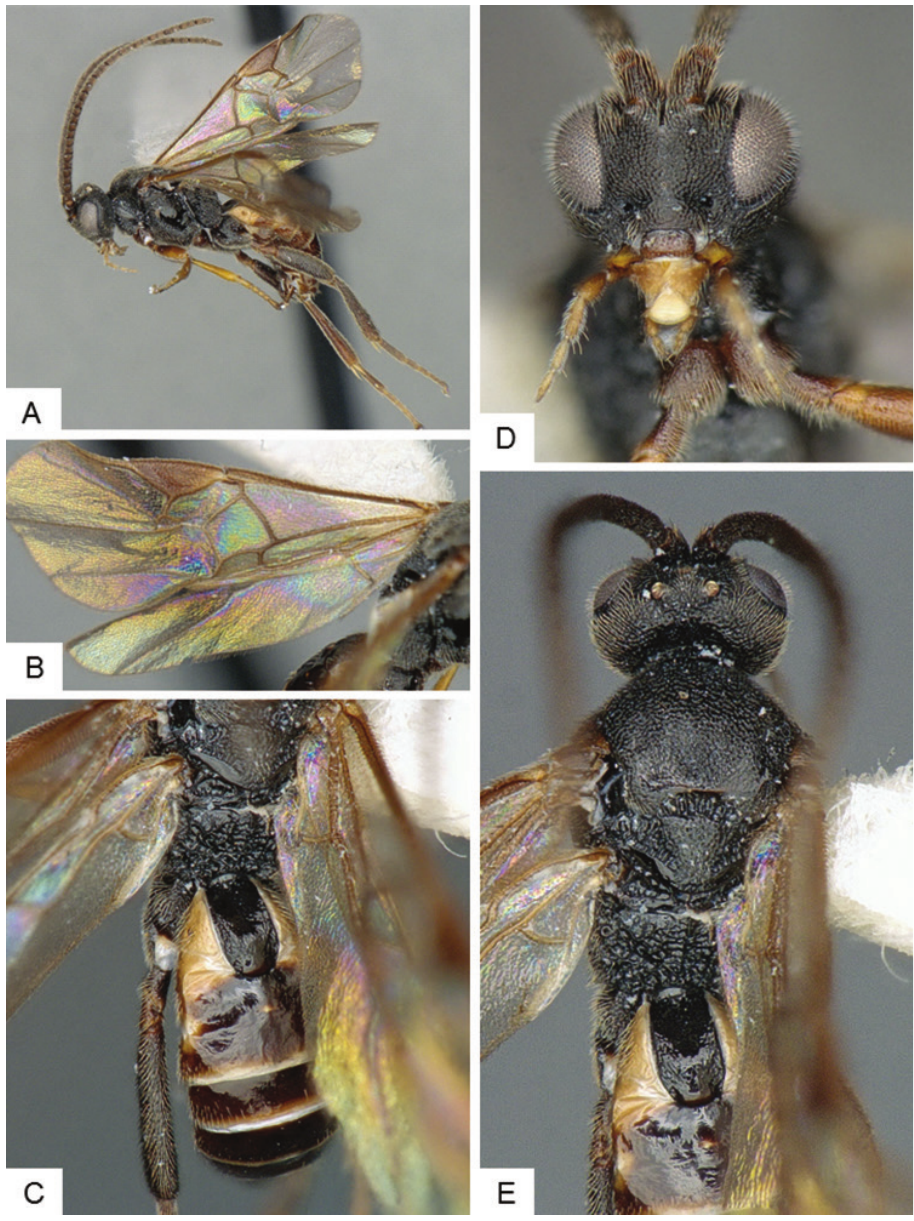
Figure 29. Microplitis sp. near lugubris . A Habitus, lateral B Fore wing and hind wing C Metasoma (partially), dorsal D Head, frontal E Head and mesosoma,